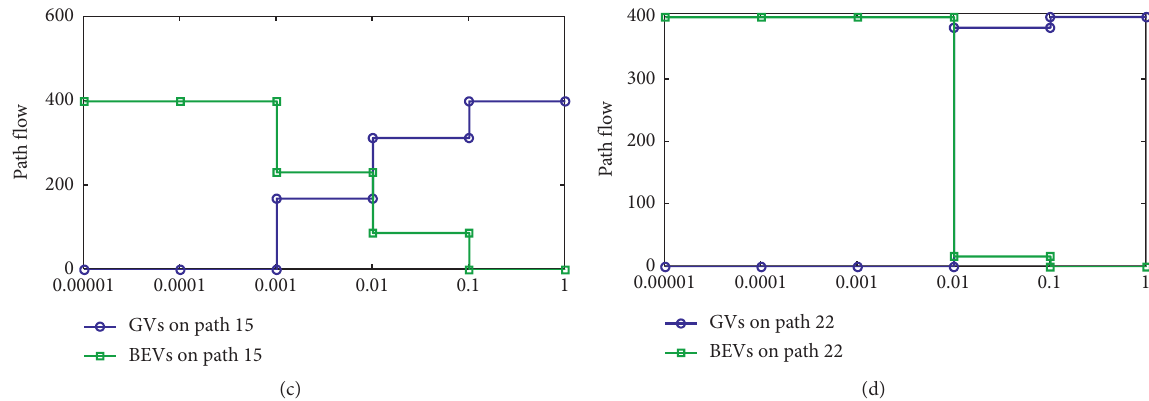
Figure 5: Changing unit operating cost of BEVs of each O-D pair in Nguyen–Dupuis’ network. (a) O-D pair (1, 2). (b) O-D pair (1, 3). (c) O- D pair (4, 2). (d) O-D pair (4, 3).